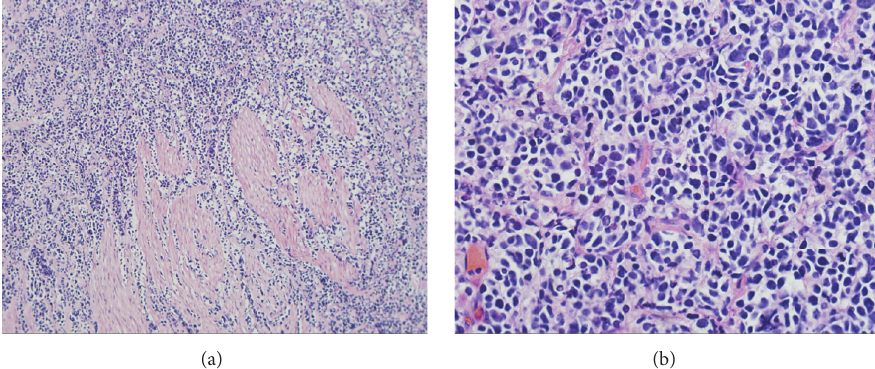
Figure 2: (a) Dark tumor cells fill stroma, splaying pink smooth muscle bands to the left (H&E, 100x). (b) Tumor nuclei are irregular, with scant cytoplasm, with some showing spots of nuclear clearing suggestive of salt and pepper, with some tumor cells juxtaposed to suggest molding, and with many pyknotic nuclei, indicative of a rapidly growing